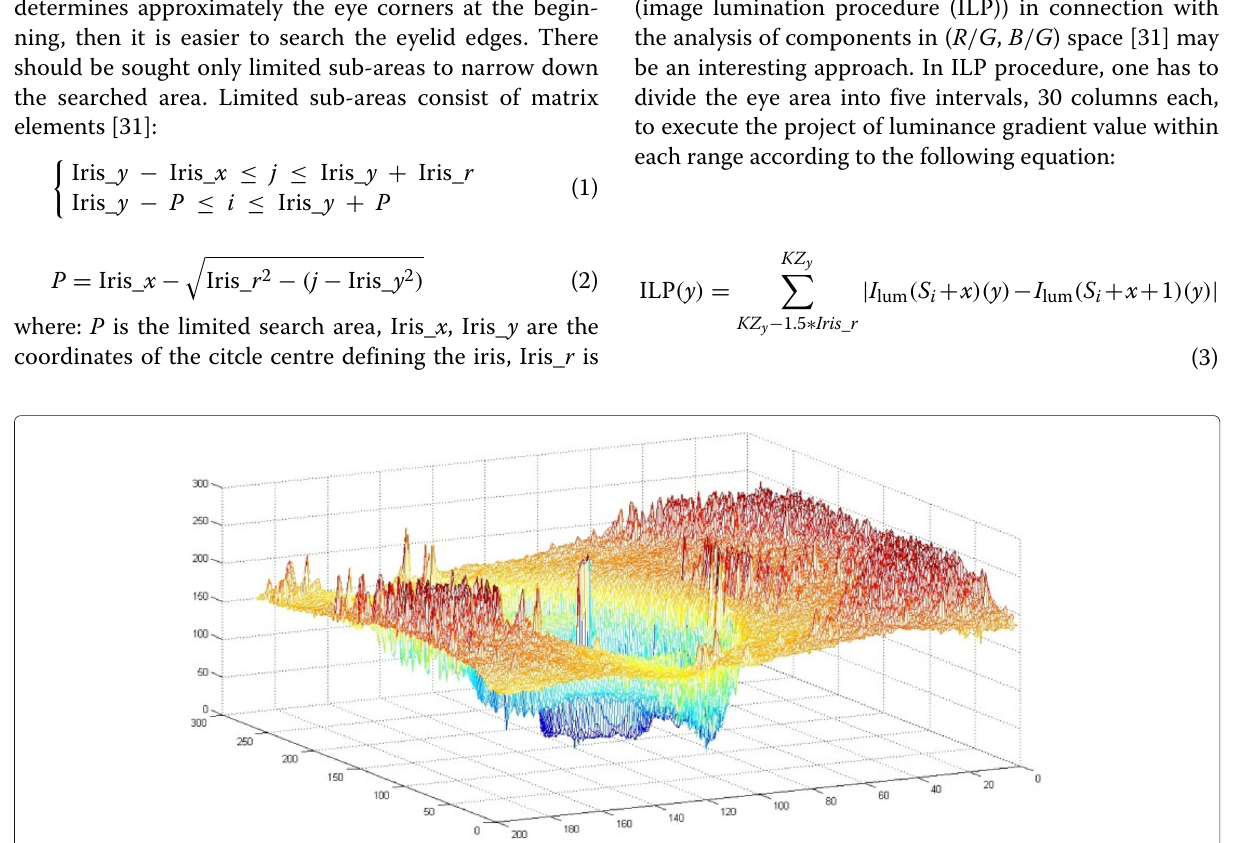
Fig. 2 Three-dimensional image of the eye area, presented in different levels of